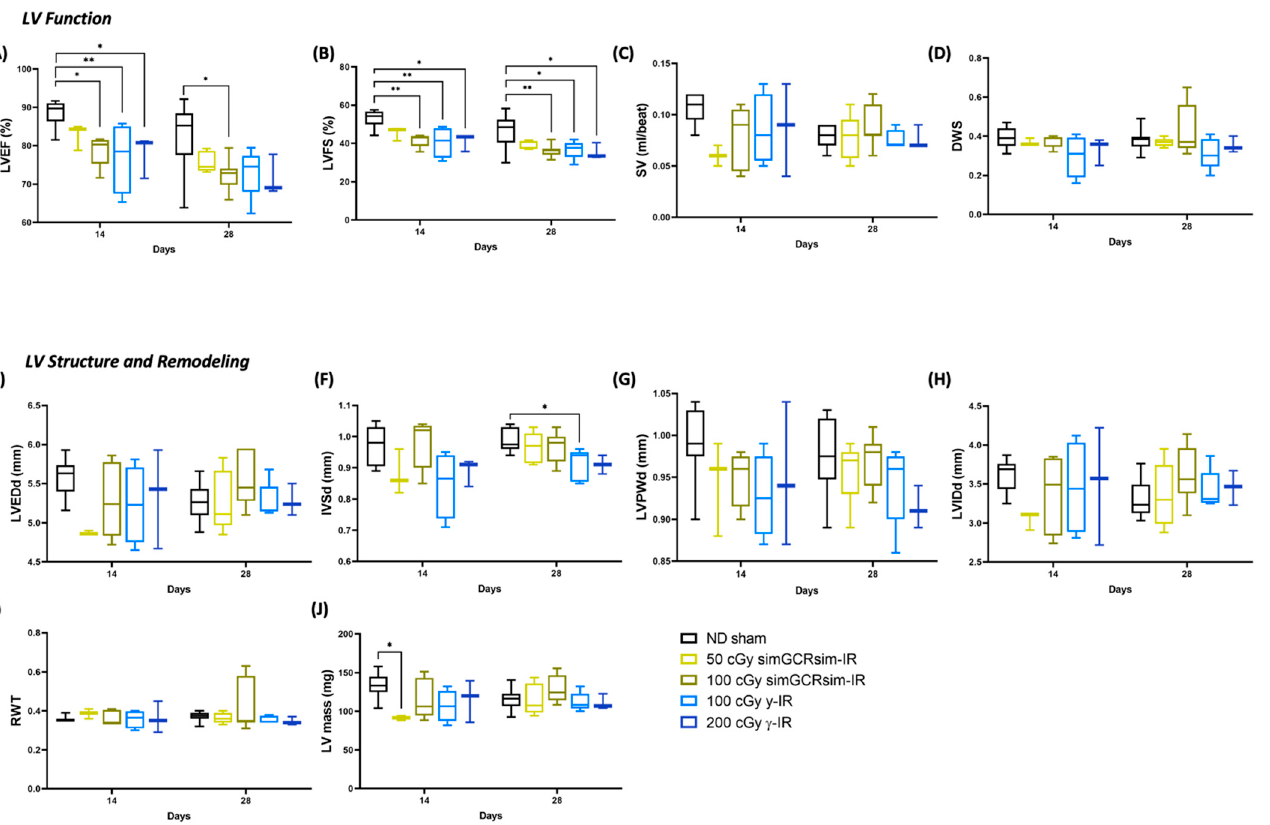
Figure 2. Longitudinal echocardiography results in C57BL/6J male mice at 14 and 28 days after gamma ( γ ) and simGCRsim irradiation. Three-month-old male C57BL/6J mice were irradiated with simGCRsim-IR (50 and 100 cGy) or gamma ( γ )-IR (100 and 200 cGy). Left ventricular (LV) function is represented by ( A ) ejection fraction, ( B ) fractional shortening, ( C ) stroke volume (SV), and ( D ) radial wall strain (DWS). Parameters of LV dimensions and remodeling are represented by ( E ) LV end diastolic diameter, ( F ) intraventricular septal thickness, ( G ) LV posterior wall thickness, ( H ) LV internal cavity diameter, ( I ) relative wall thickness, and ( J ) LV mass. No-IR normal-diet (ND)-fed mice served as controls. n = 3–10 mice per treatment condition and time point (50 cGy simGCRsim and 200 cGy gamma-IR at 14 days, n = 3; the rest of samples for 14 and 28 days, n = 5–10); p -values were calculated using one-way ANOVA. ** p < 0.01, * p <